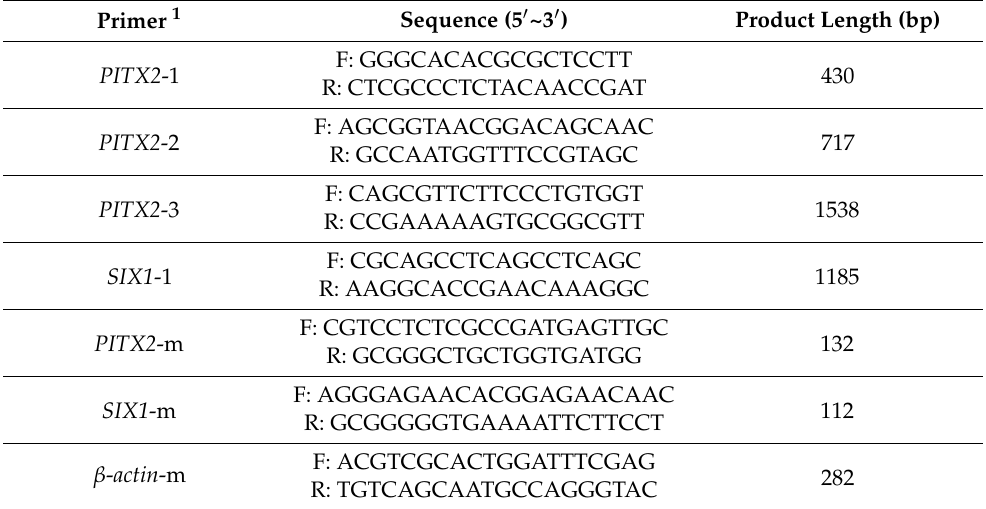
Table 1. Primer sequences for amplifying the exons and qPCR of the chicken PITX2 and SIX1